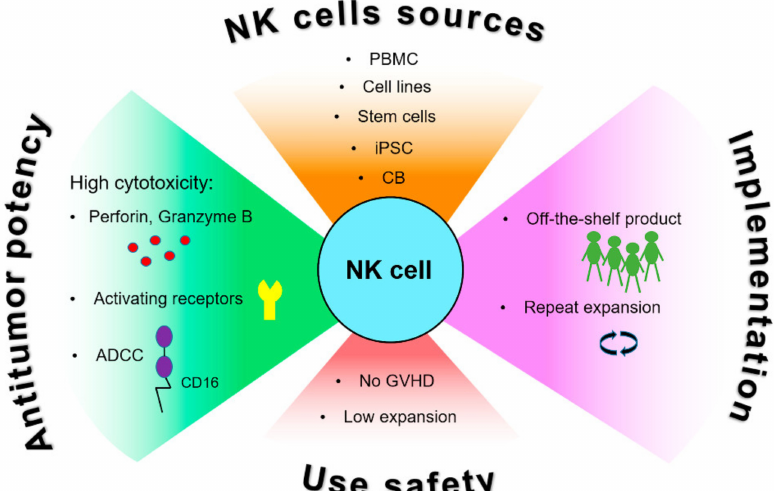
Figure 1. Advantages of NK cells for anti-cancer immunotherapy. NK cells have high innate cytotoxic activity caused by different mechanisms involving production of cytotoxic granules containing perforin and granzymes, multiple activating receptors and antibody-dependent cytotoxicity (ADCC) enhancing their anti-tumor potential. Different sources for obtaining and safety of use NK cells facilitate their application for research and potential clinical practice. Abbreviations: CB, cord blood; GvHD, graft versus host disease; iPSC, induced pluripotent stem cells; PBMC, peripheral blood mononuclear